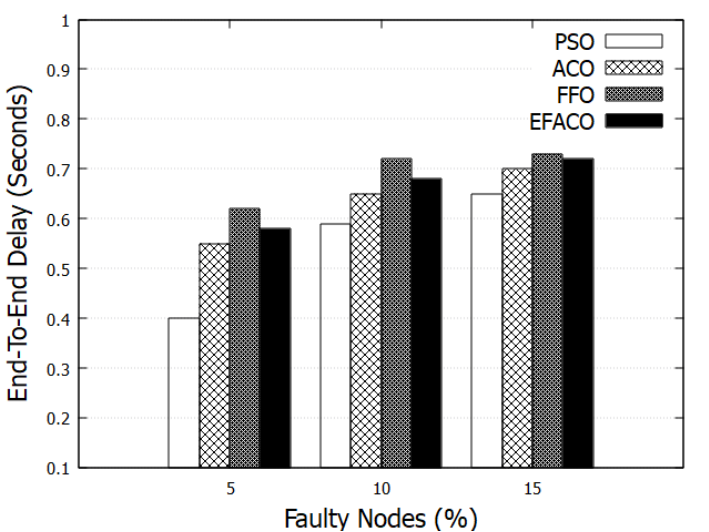
Figure 10. Comparison between proposed PSO, ACO, FFO, EFACO for End-to-End Delay with faulty